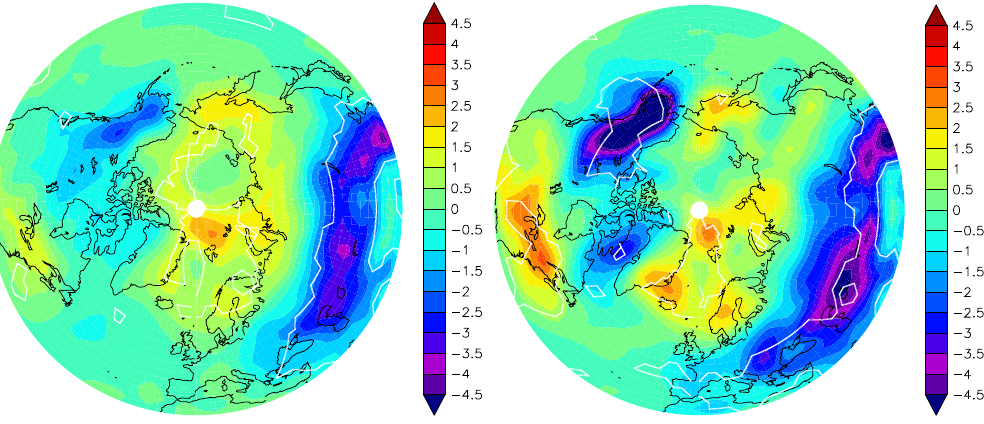
Fig. 7. NH DJF surface temperature difference 1T = T S − EPP − T S − noEPP . Left: all years, right: only years without SSWs. Red/blue colours indicate positive/negative